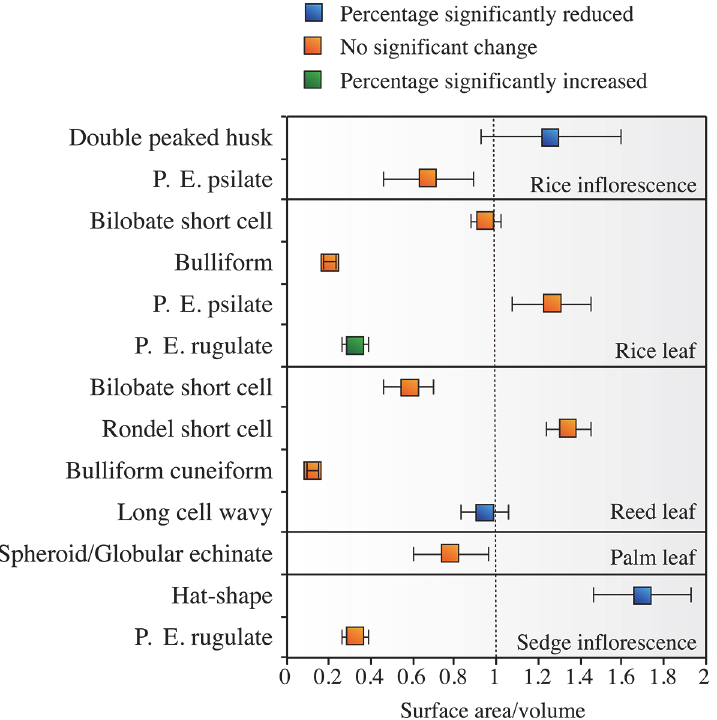
Fig 4. Calculated surface area to bulk (SA/V) ratios for selected morphotypes in the various modern plant assemblages. Error bars indicate 1 σ standard deviation among several measured individual phytoliths of the same morphotype (S1 Table). The relatively large variation reflects the natural variability in phytolith sizes. Values above 1 indicate relatively unstable morphotypes while values below 1 indicate relatively stable morphotypes. Note that the same morphotype (e.g., psilate parallelpipedal elongated, here denoted as P.E. psilate) may have very different SA/V ratio in different plant parts (or in different plant species, e.g., bilobate short cells from rice leaves vs. reed leaves), depending on their overall size — the larger the morphotype the lower its SA/V value and the higher its stability. This observation indicates that bulkiness, as affected by size, are important factors determining the stability of phytolith